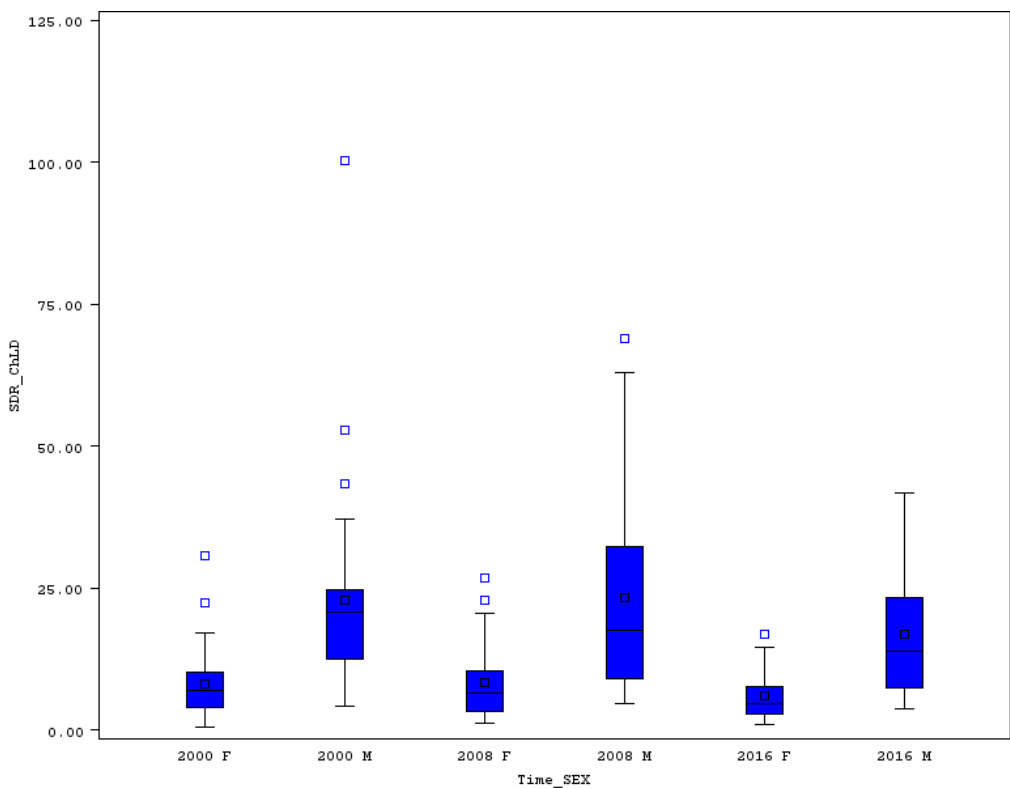
Figure 6. Boxplot of premature SDR for chronic liver disease in EU countries for males and females in selected years. Source: Own calculations based on Eurostat database [20].